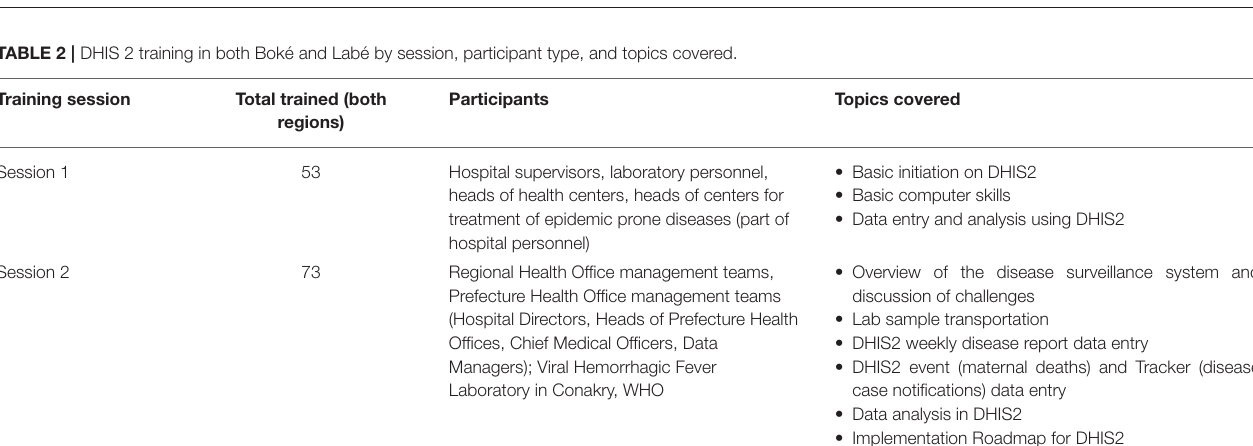
FIGURE 3 | Design of data flow for individual case notifications in DHIS2 tracker in Guinea.